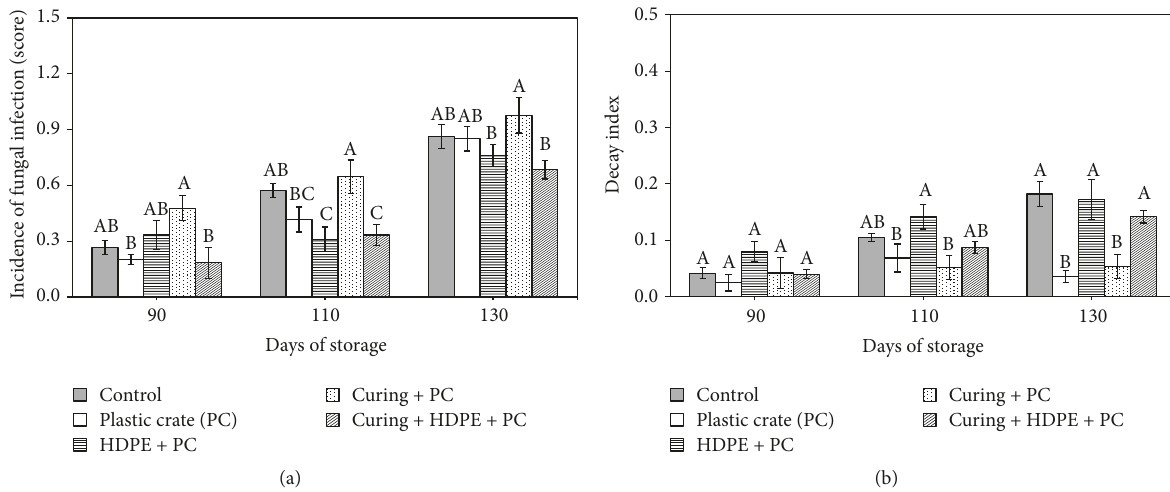
Figure 6: Incidence of fungal infection score (a) and decay index (b) of radish roots during storage at low temperature under different packaging treatments. Vertical bars represent ± SE of mean. For each evaluation day, different letters indicate significant differences ( 𝑃 < 0.05 ) among treatments.